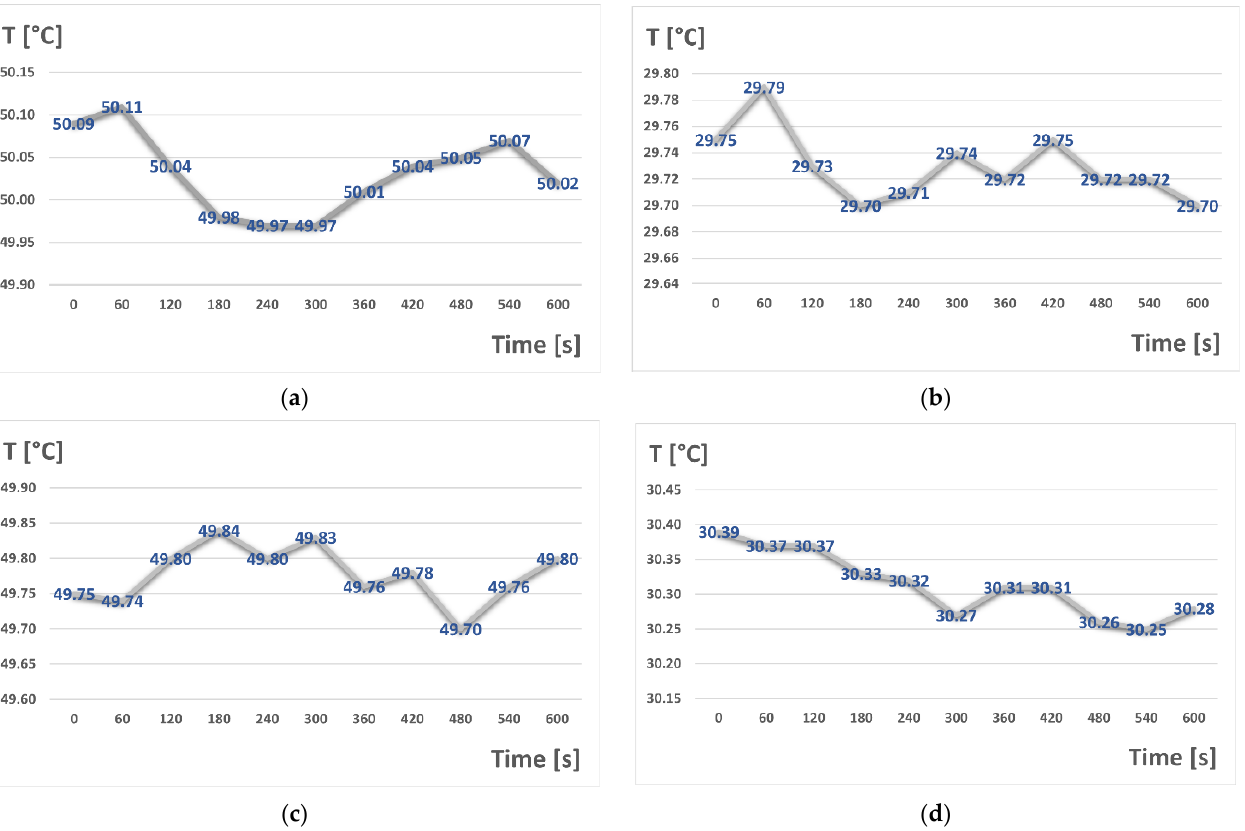
Figure 3. The temperature variation during testing ( a ) G20-outlet; ( b ) G20-inlet; ( c ) G222-outlet, and ( d ) G222-inlet.